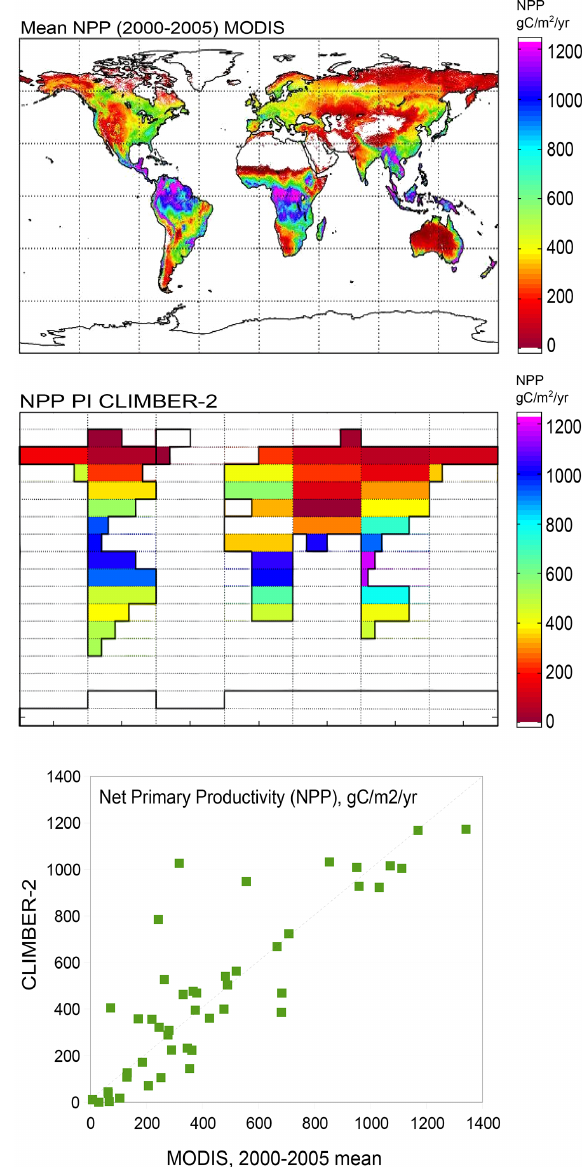
Figure 4. Comparison of NPP, which has a control on carbon input to soils, for MODIS data set (top, mean 2000–2005) and CLIMBER-2 model for PI(eq) (modelled year 1950) plotted on the same scale (gCm − 2 yr − 1 ). MODIS data upscaled to CLIMBER- 2 grid scale are shown against equivalent points for CLIMBER-2